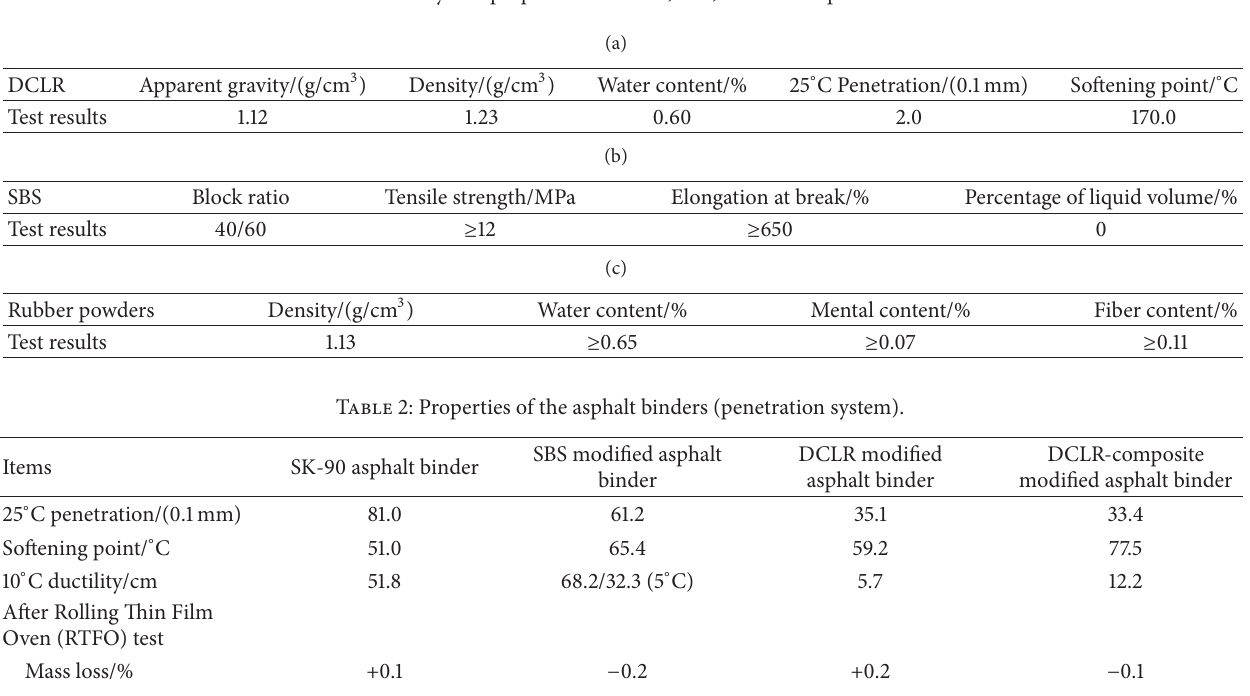
Table 1: Physical properties of DCLR, SBS, and rubber powders.